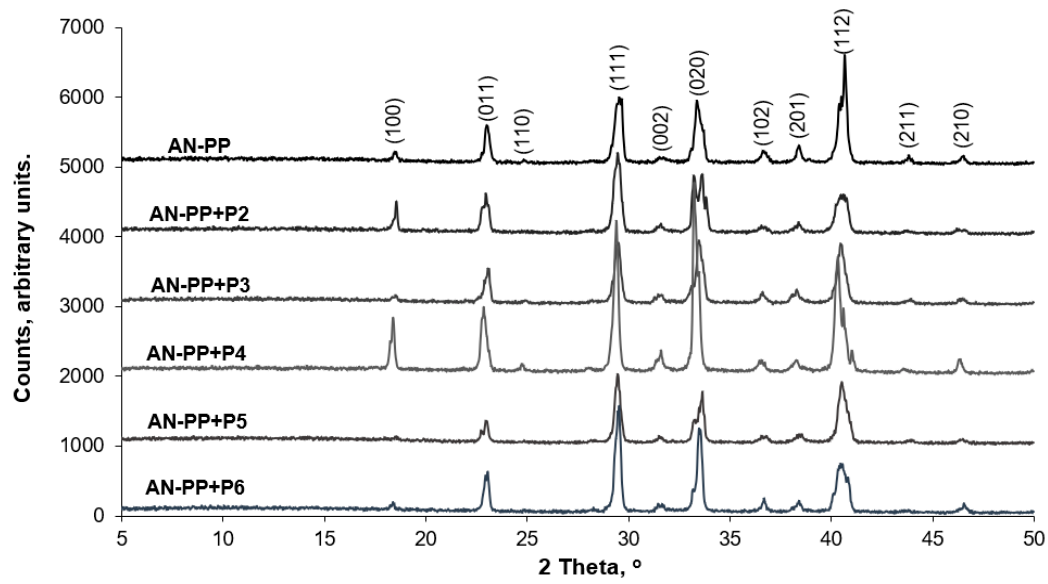
Figure 2. The XRD patterns of the ANFO obtained by mixing AN-PP with a fuel sample: P2–P6.